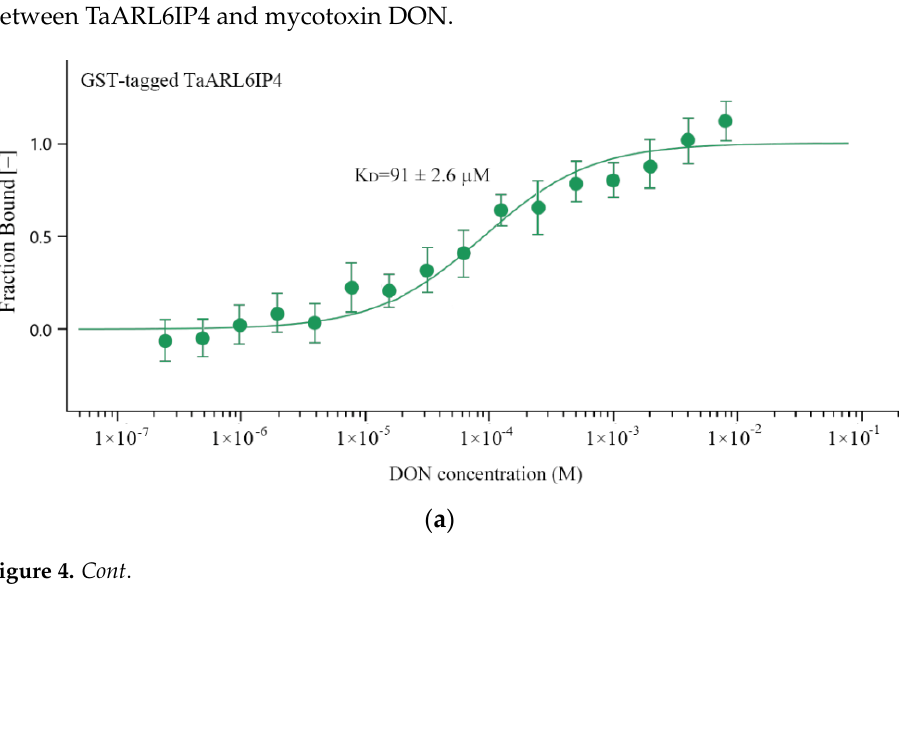
Figure 3. Antifungal activity analysis of TaARL6IP4. ( a ) Growth inhibitory effect of the TaARL6IP4 peptide toward F. graminearum and A. alternata . ( A , B ) F. graminearum spores treated with PBS or 50 µM of TaARL6IP4 for 24 h at 28 °C, respectively. ( C , D ) A. alternata spores treated with PBS or 50 µM of TaARL6IP4 for 24 h at 28 °C, respectively (Bar = 40 µm). ( b ) TaARL6IP4 inhibited the germination of F. graminearum spores by targeting the fungal plasma membrane. FITC- ahx-labeled TaARL6IP4 peptide (50 µM) and PBS (control) were used for the treatment of F. graminearum 5035 spores in the dark at 25 °C for 1 and 18 h, respectively (Bar = 20